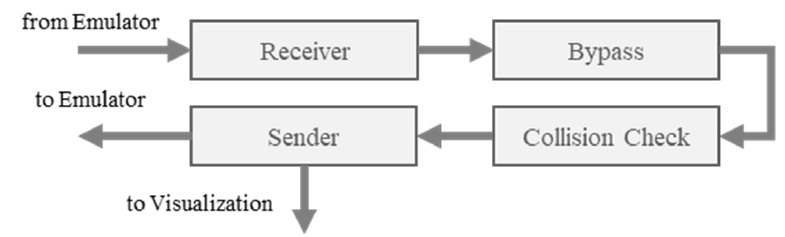
Figure 3. ACS core module that is used to check the bypass control and collision.